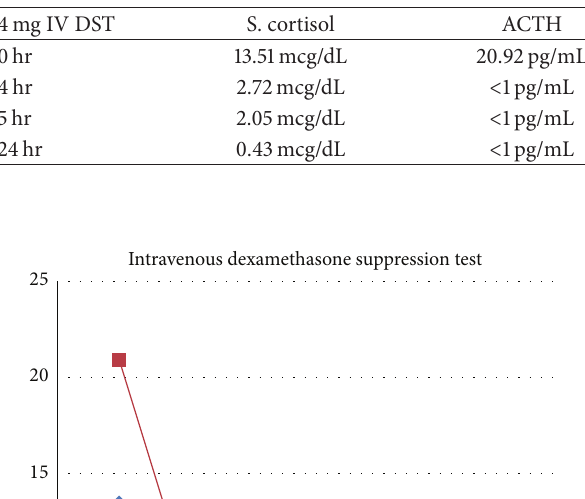
Table 3: ACTH and cortisol dynamics during the intravenous dexamethasone suppression test.